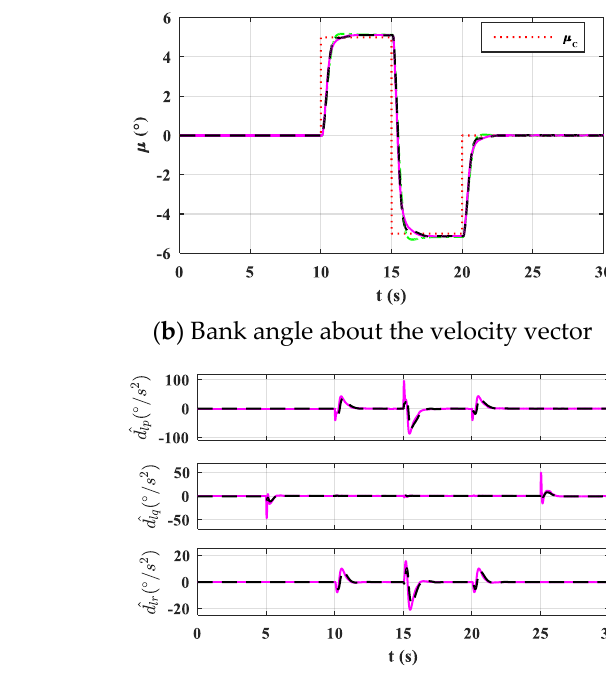
Figure 6. The nominal response of the tailless aircraft model controlled using NDI-proportional-integral elements (PI), nonlinear disturbance operator based NDI (NDI-DO), and NDI- anti-windup (AW).